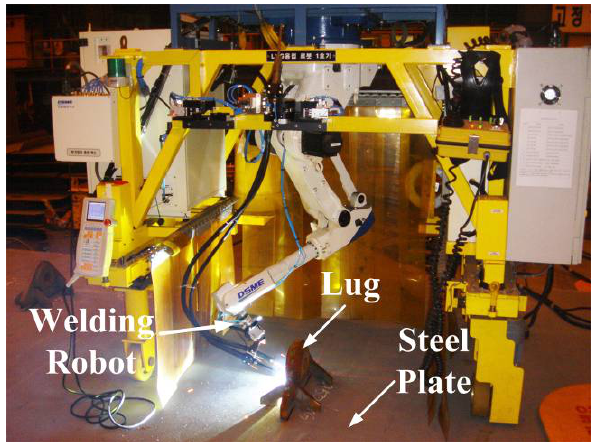
Figure 1. An automatic lug welding system with an overhead type robot manipulator developed by Daewoo Shipbuilding and Marine Engineering (DSME) Co.,